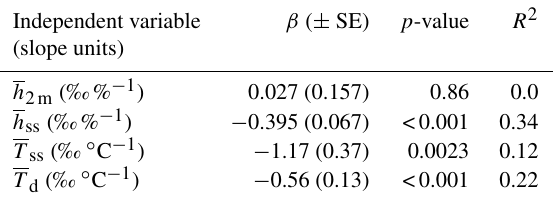
Table 3. Explanation of deuterium excess ( d ) using simple regres- sions against various metrics that characterize source conditions. β is the regression coefficient, and SE is the standard error. We show results from simple linear regressions with four different indepen- dent variables: evaporation site relative humidity ( h 2m ), evapora- tion site relative humidity relative to sea surface temperature ( h ss ), sea surface temperature ( T ss ), and 2m dew point ( T d ).